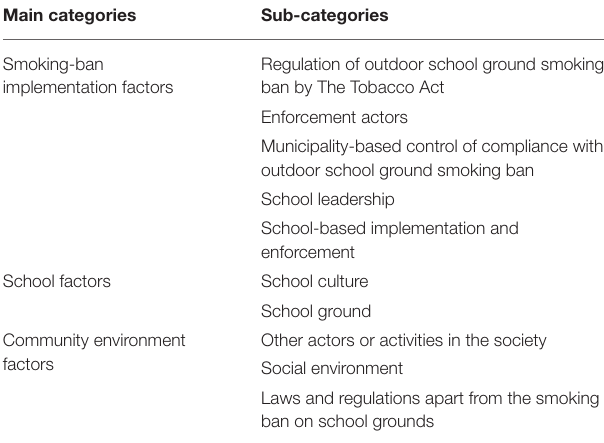
TABLE 1 | Main categories and